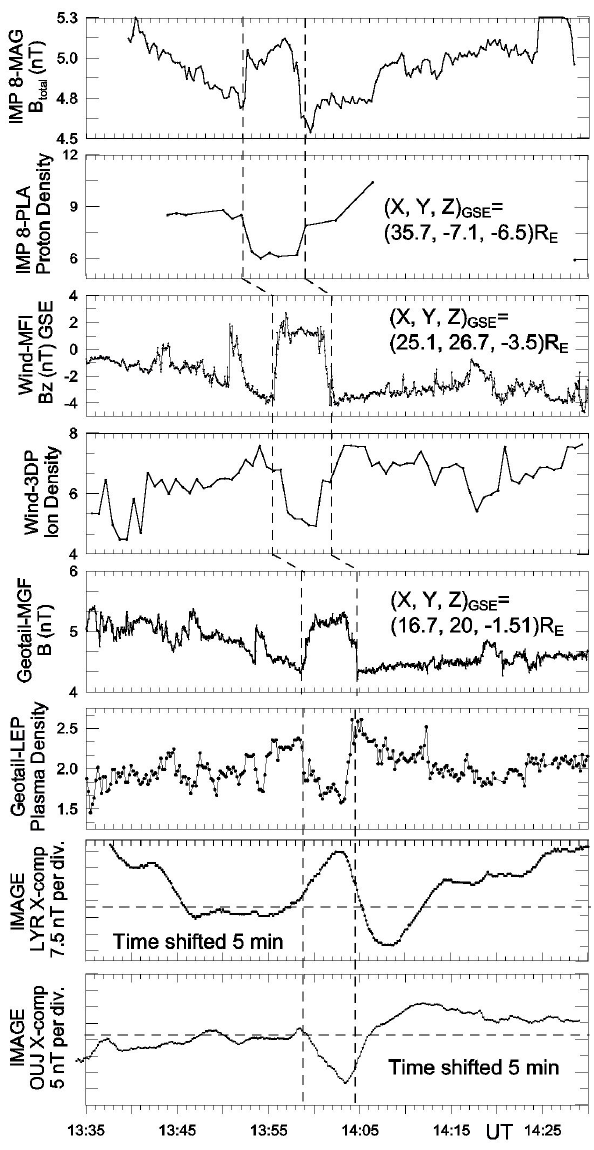
Fig. 7. From top to bottom, magnetic field (in nTs) and solar wind particle density (in cm − 3 ) from IMP-8, Wind and Geotail. The two bottom panels show the ground signatures (PN- and NP-type for LYR and OUJ, respectively) produced by the negative solar wind pressure pulse, which is restricted between the two vertical dashed